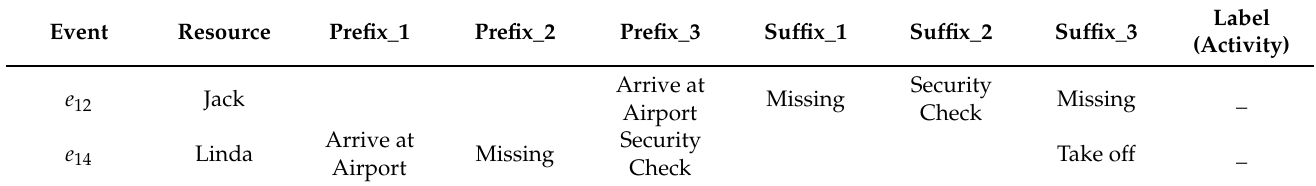
Table 4. The example dataset constructed from E missing